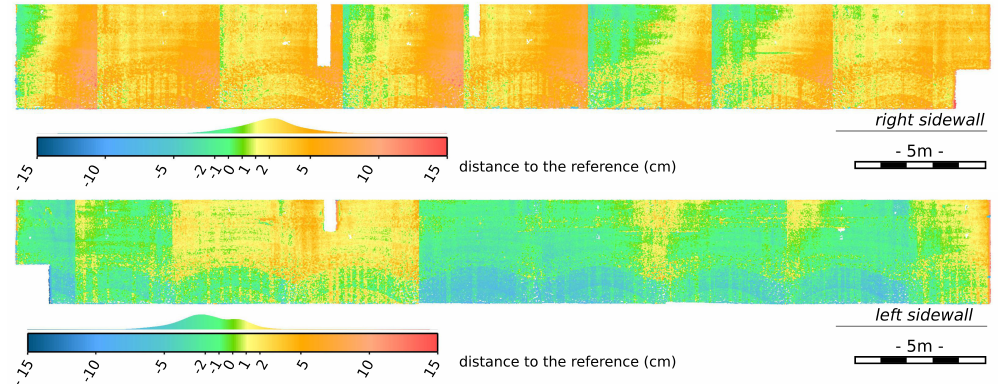
Figure 16. Distribution of distances between MSS and TLS after tilt angle correction, (top) for the right wall and (bottom) for the left wall.